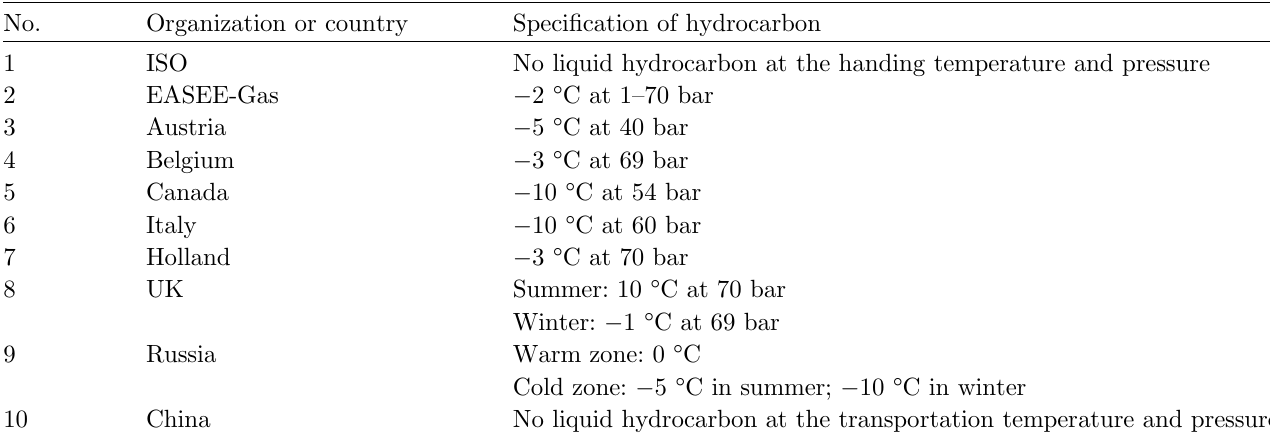
Table 1. The speci fi cation of hydrocarbon dew point of international organization and countries.